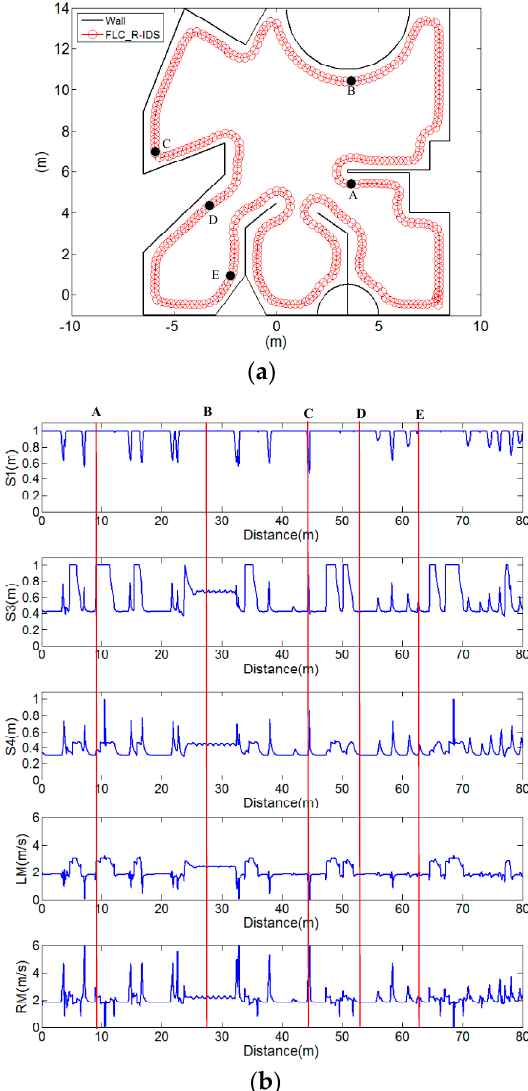
Figure 13. ( a ) Mobile robot path tracking, ( b ) ultrasonic sensor values, and the left-wheel and right-wheel speeds of the robot in test environment 3 for the FLC_R-IDS method.